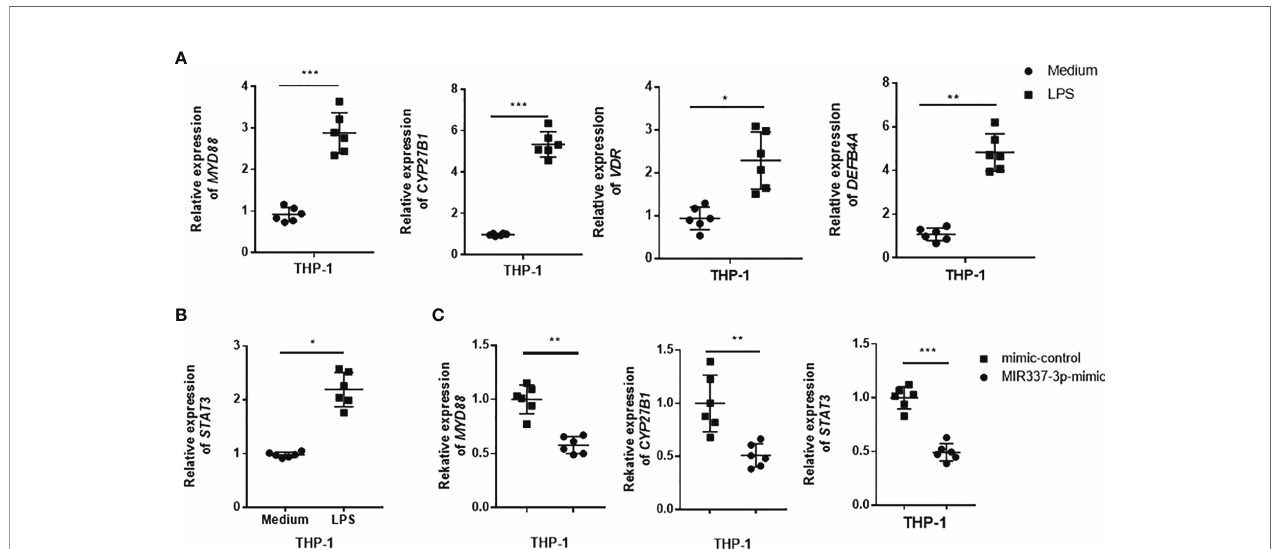
FIGURE 6 | TLR4 signaling could activate VDR-related antimycobacterial pathways, and MIR337-3p could impair both the TLR4/MYD88 signal and the VDR-related antimicrobial response. (A) shows that LPS stimulation induced MYD88 , CYP27B1 , VDR , and DEFB4A expression in THP-1 cells. Medium was taken as control. (B) shows that LPS stimulation signi fi cantly upregulated STAT3 expression in THP-1 cells. (C) shows that mimics of MIR337-3p inhibited the expression of MYD88 , CYP27B1 , and STAT3 in THP-1 cells stimulated by LPS. Data are expressed as mean ± standard errors. *P < 0.05, **P < 0.01, and ***P <